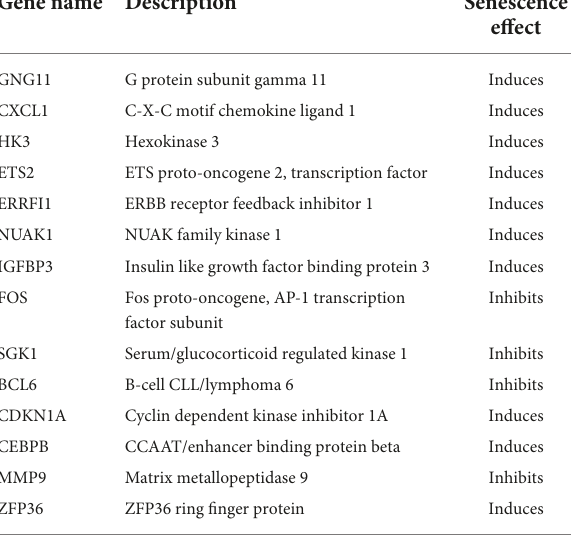
TABLE 1 Fourteen differentially expressed senescence-related genes (all upregulated genes).